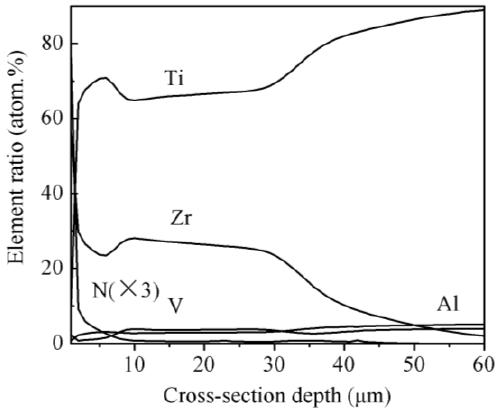
Figure 7. Elemental distribution along depth of ZrN layer on the T6Al4V alloy.